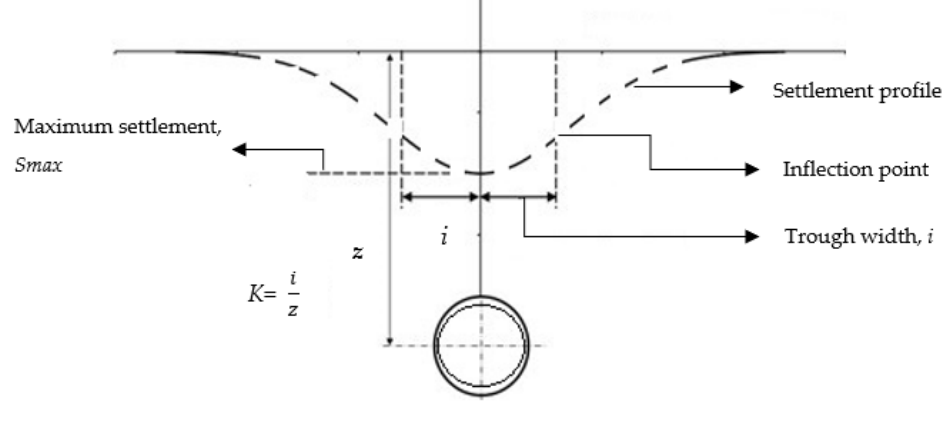
Figure 1. Ground-settlement trough.